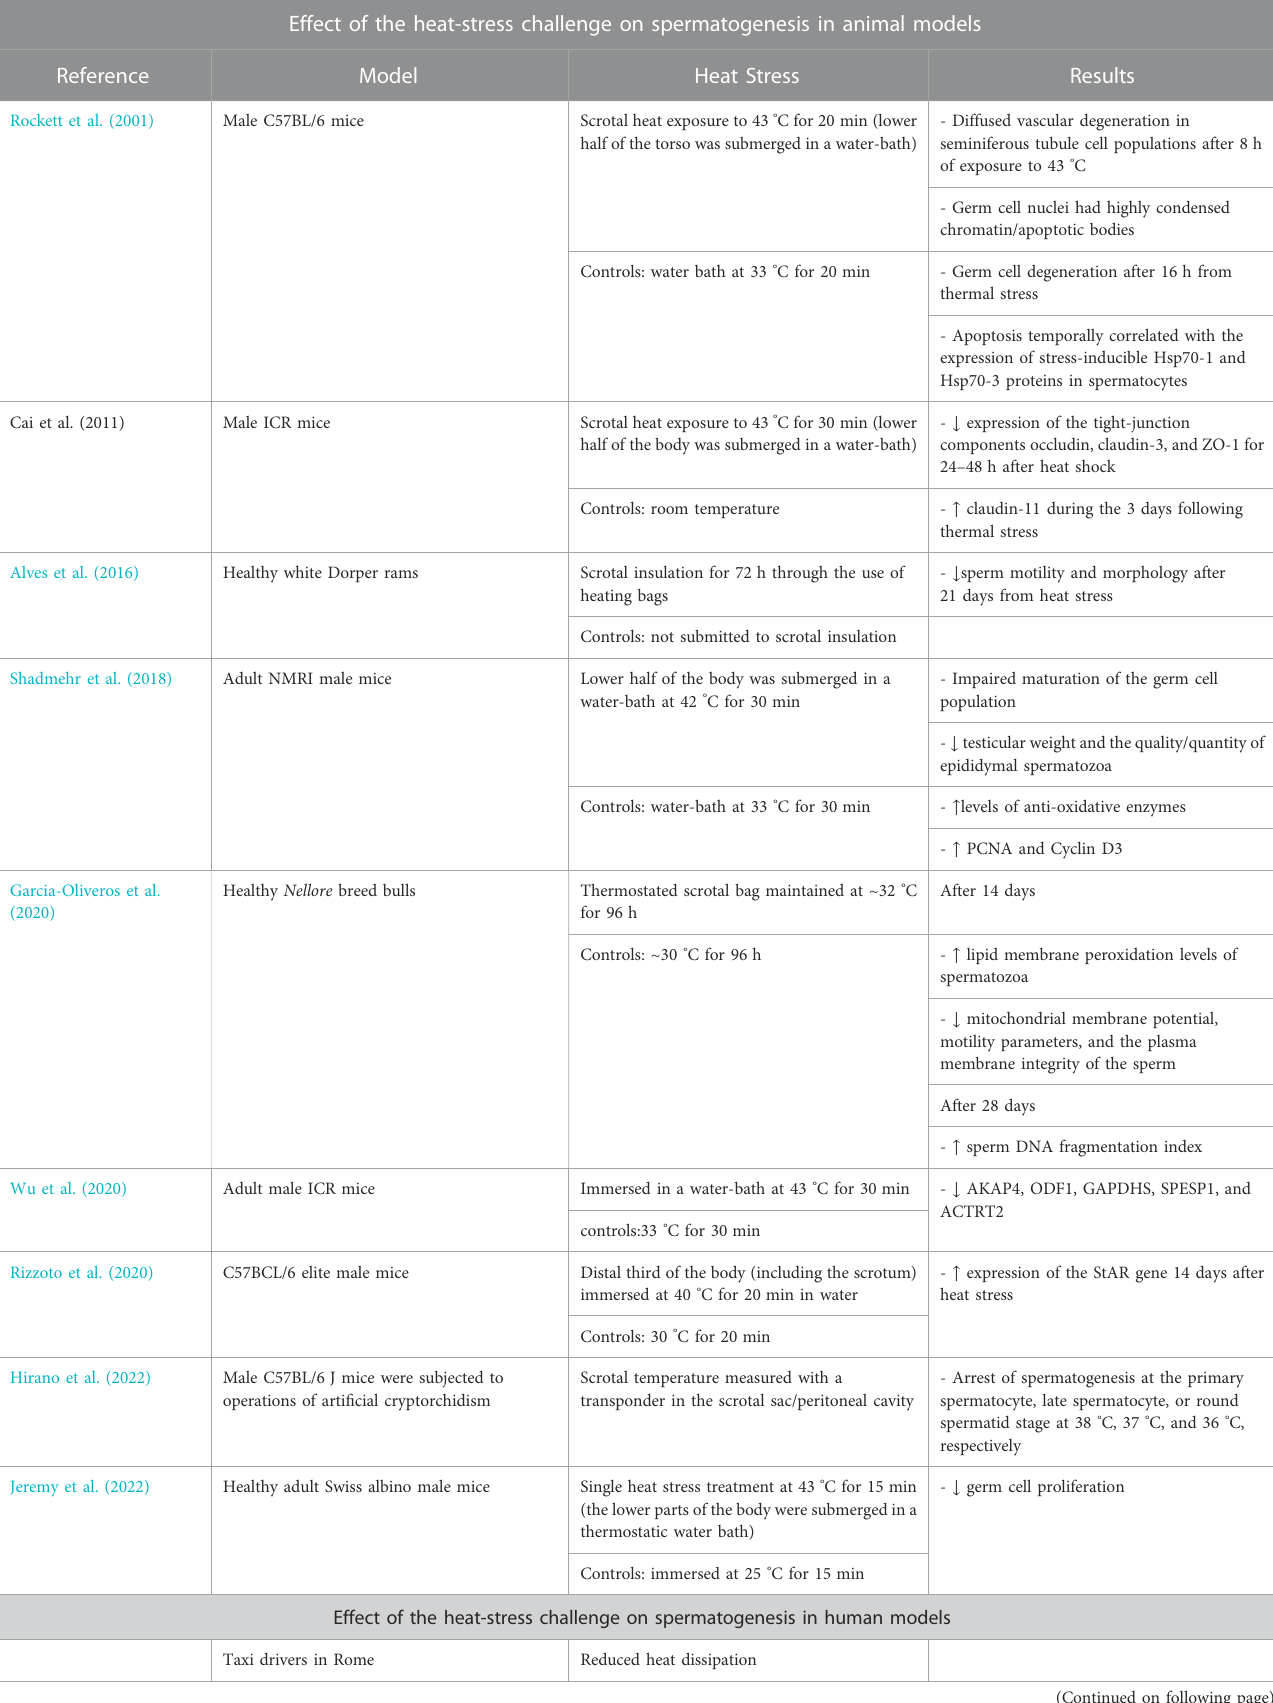
TABLE 1 Description of the studies evaluating the effect of heat stress challenge on spermatogenesis and on steroidogenesis in animal and human